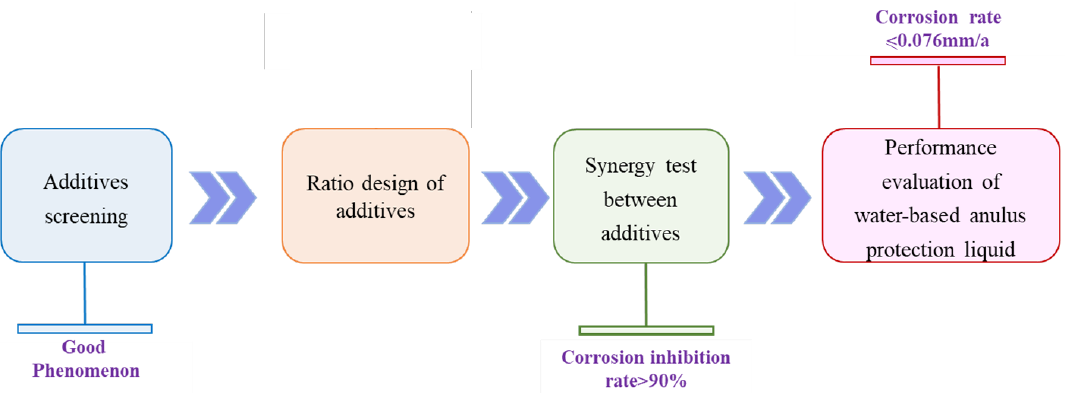
Figure 2. Design thinking for water-based annular air protective fluid.